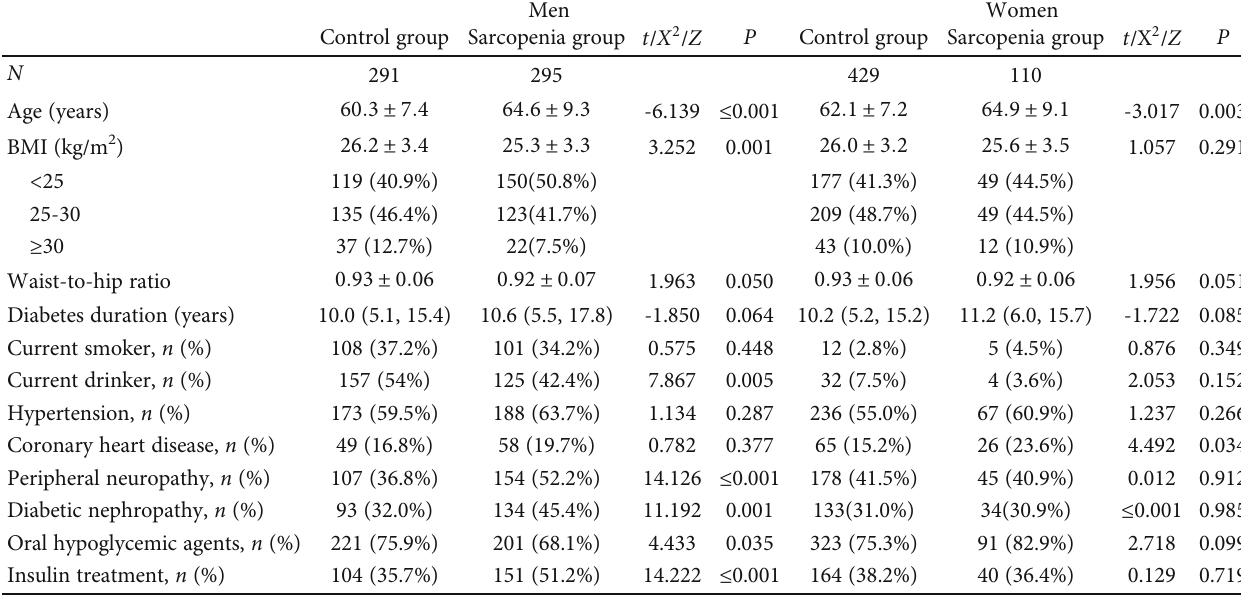
Table 1: Characteristics of the T2DM participants in the sarcopenia group and control group strati fi ed by sex.